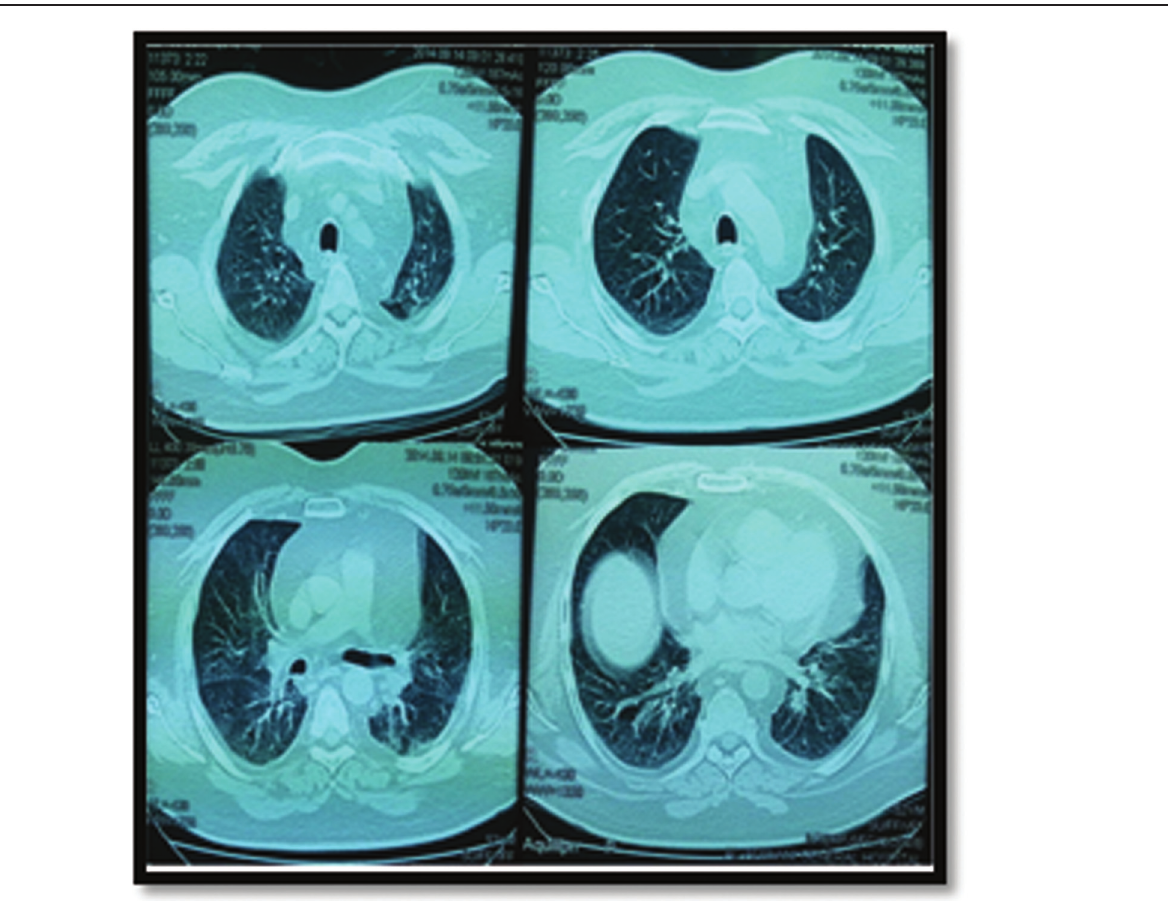
High-resolution chest computed tomography (CT) without contrast after 6 weeks on 40mg